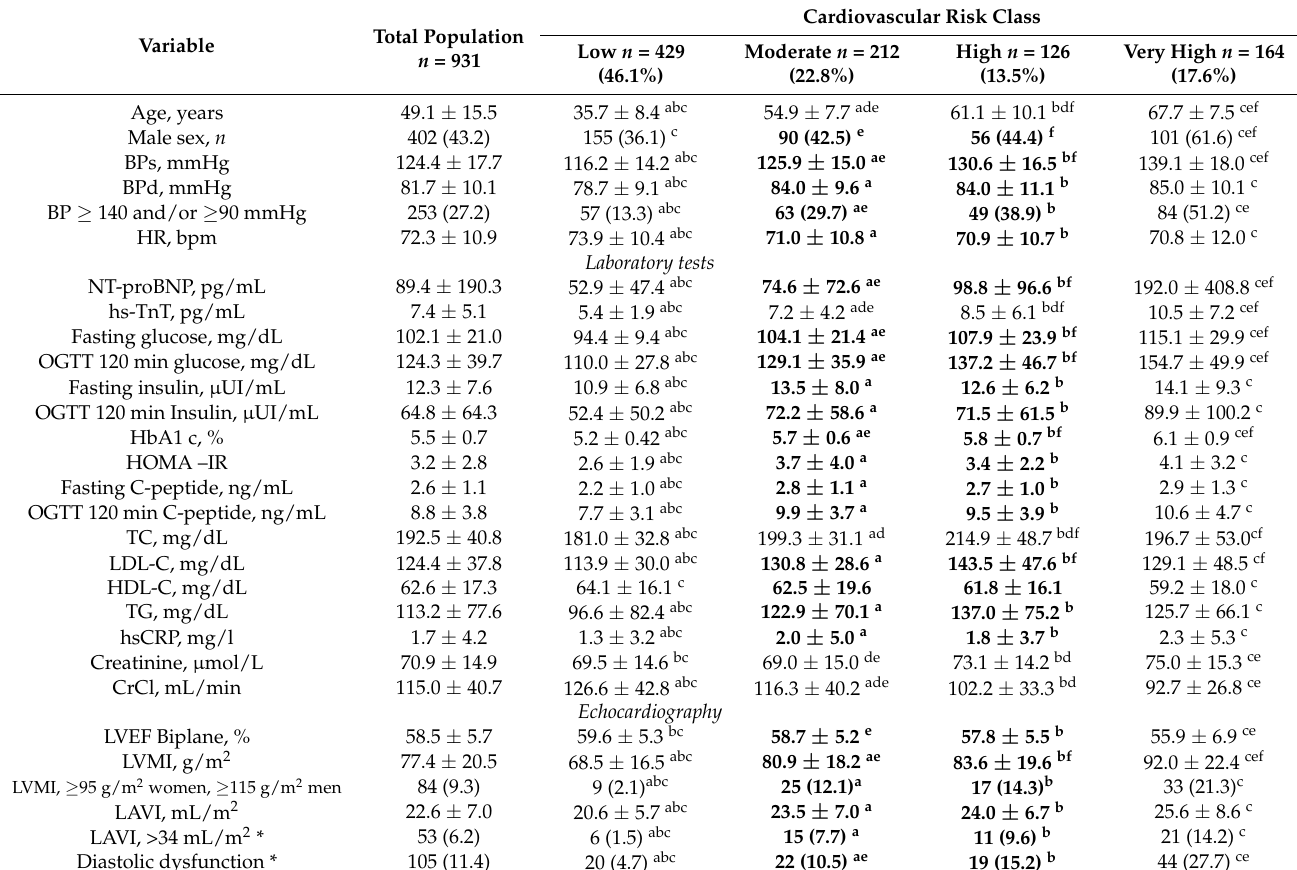
Table 1. Characteristics of the total population and of subgroup according cardiovascular risk and comparisons variables between subgroups (general information, laboratory tests,